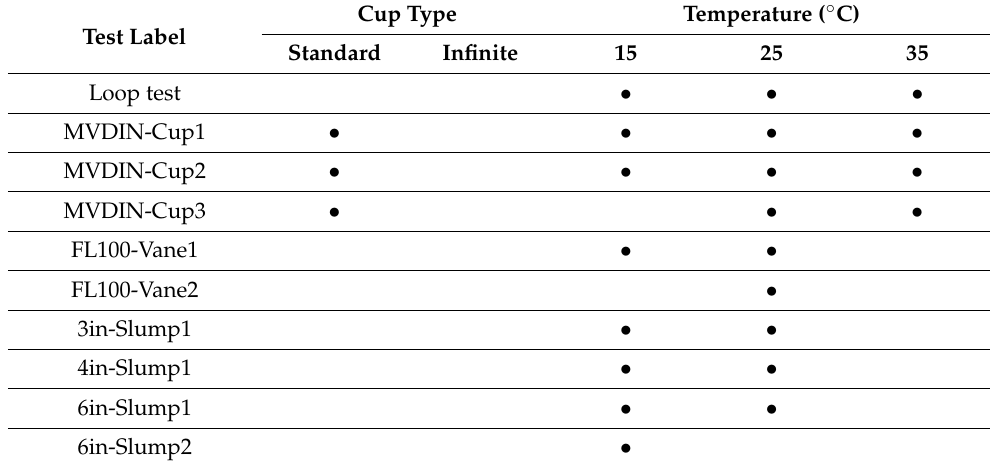
Table 3. Mine-A sample data (bullet represents measurement technique performed).